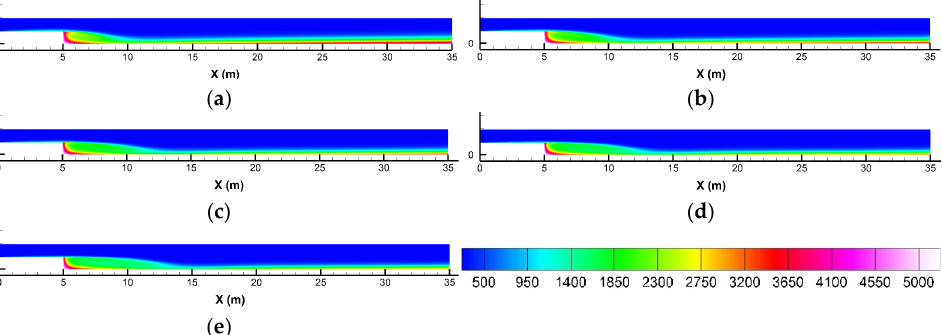
Figure 4. Temperature contours at various Reynolds numbers; ( a ) 200, ( b ) 300, ( c ) 400, ( d ) 500, and ( e ) 600.